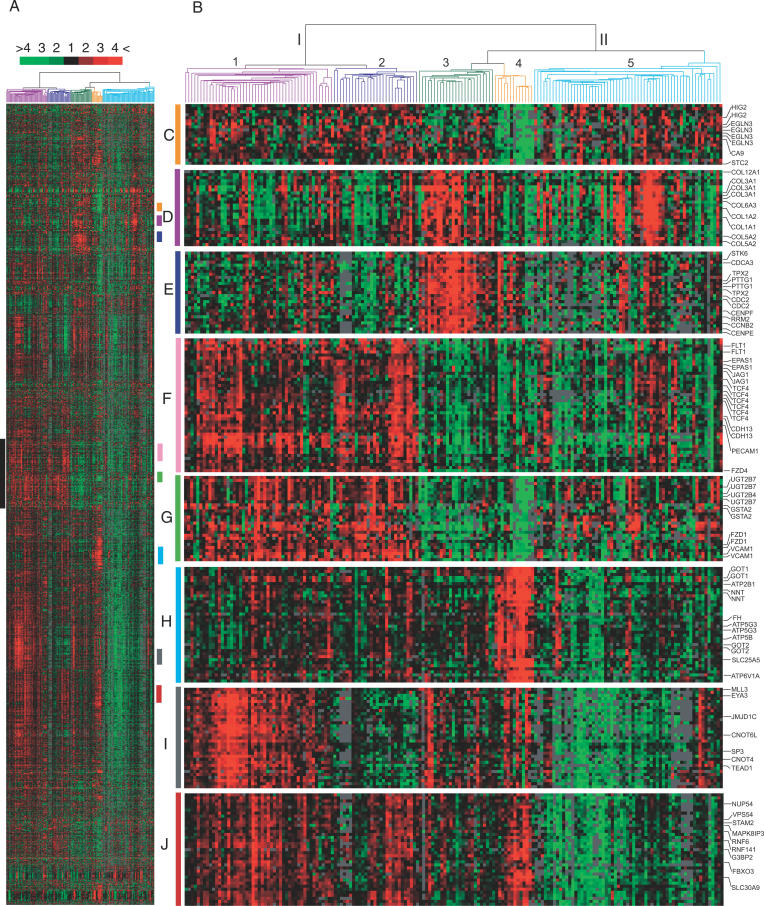
Unsupervised Hierarchical Clustering Analysis of 177 cRCCs(A) Overview of the gene expression patterns of 3,674 genes whose expression varied more than 3-fold in at least ten samples across the 177 samples. Each row represents a single gene, and each column an experimental sample. Colored bars identify the locations of the inserts in (C–J). The degree of color saturation corresponds with the ratio of gene expression shown at the top of the image.(B) Dendrogram representing similarities in the expression patterns between experimental samples. Samples were separated into two main groups and five subgroups (one in purple, two in blue, three in dark green, four in orange, and five in light blue) by the clustering algorithm.(C) Hypoxia-induced gene cluster.(D) Collagen gene cluster.(E) Proliferation gene cluster.(F–I) Genes distinguishing the two main groups (subgroups 1 and 2 from subgroups 3, 4, and 5).(H) Energy generation gene cluster.(J) Genes downregulated uniquely in subgroup 5.